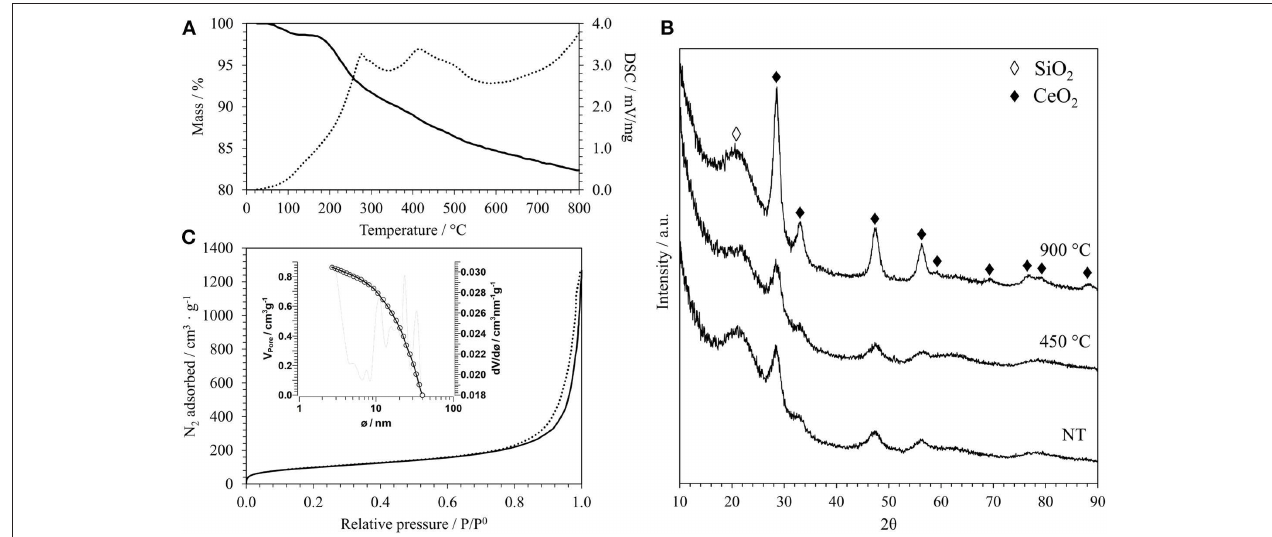
FIGURE 1 | (A) TGA/DSC curves of the aerogel sample A_15_CeO 2 _NT: TG (bold line), DSC (dashed line). (B) XRD patterns of the same sample after supercritical drying (NT) and after thermal treatments at 450 ◦ C and 900 ◦ C. (C) N 2 -physisorption isotherm of the same sample after thermal treatment at 900 ◦ C (adsorption branch: bold line; desorption branch: dashed line) and pore size distribution calculated from the desorption branch (inset).